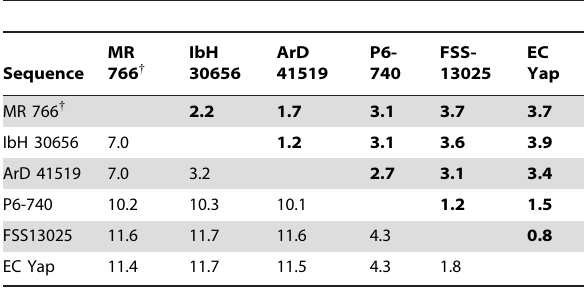
Table 3. Pairwise comparisons of African and Asian Zika virus